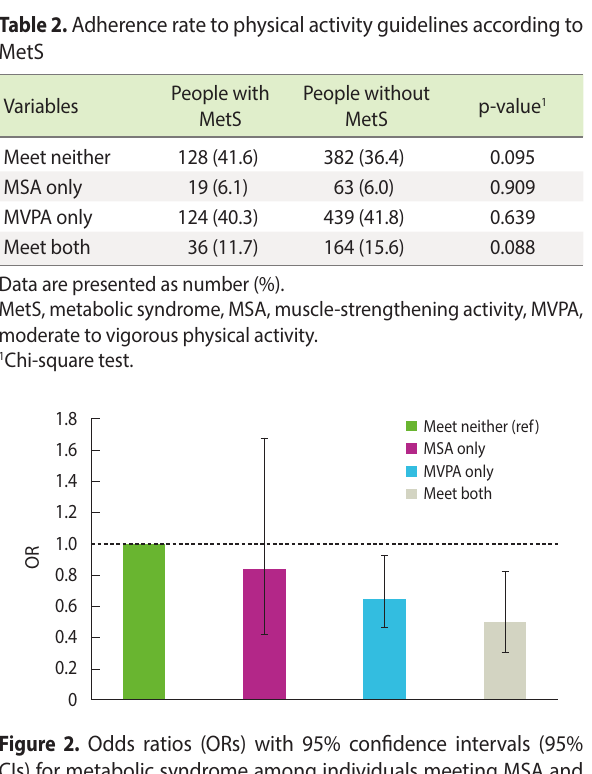
Table 3. Adjusted ORs detailing the independent and combined ef- fects of meeting the MSA and MVPA guidelines 1